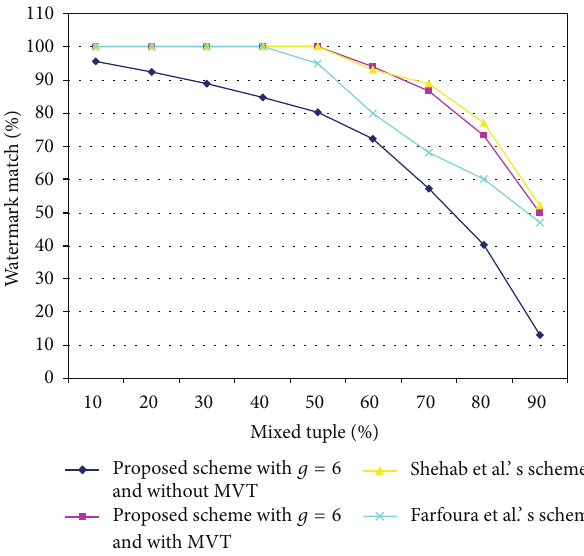
Figure 9: Comparison of results for resilience to a mix-match attack of the two proposed schemes and the other two